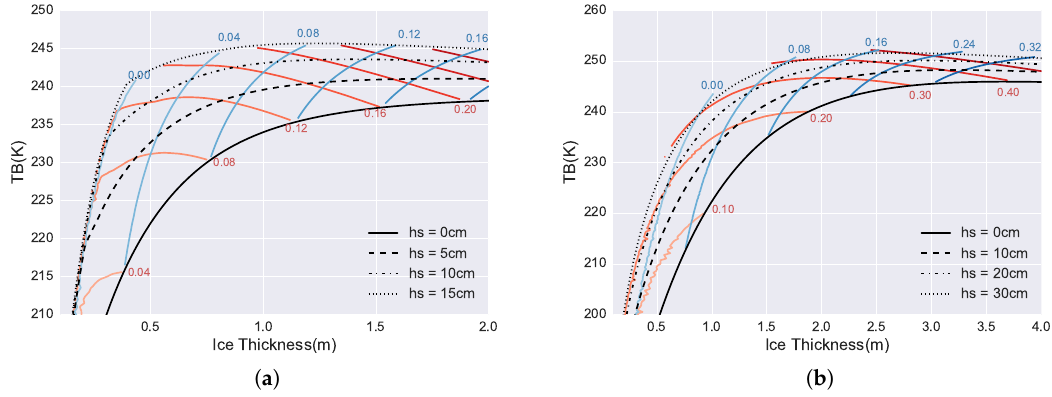
Figure 2. The relationship between TB and sea ice parameters ( hi and hs ) under typical Arctic winter conditions (surface temperature is 30 ◦ C) for FYI ( a ) and MYI ( b ). The corresponding constant − freeboard lines are shown. Constant FB snow lines and corresponding values (in m ) of FB snow are in red, and those for FB ice in